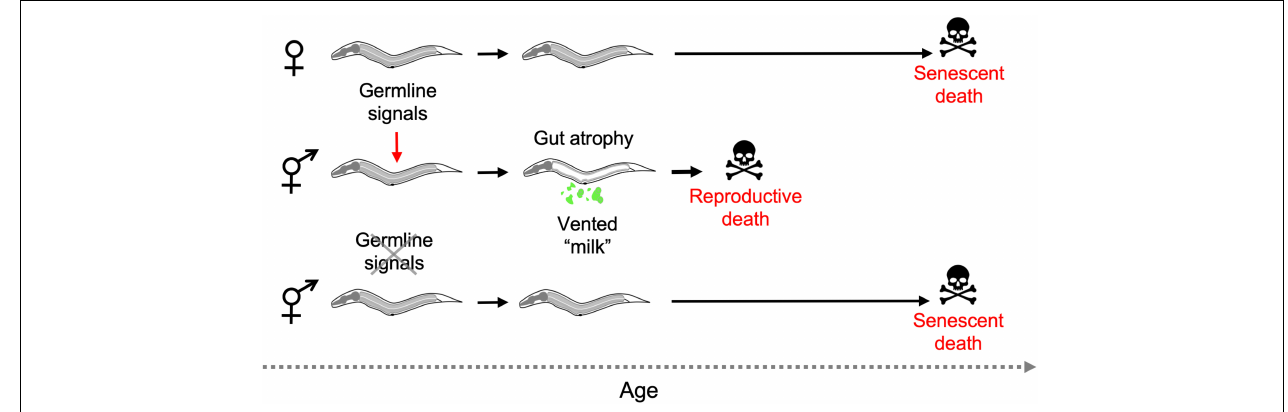
FIGURE 6 | Aging and death in Caenorhabditis females and hermaphrodites (simplified working model). In the absence of mating only hermaphrodites exhibit reproductive death, and this is triggered during reproductive maturation by signals from the germline. Removal of the germline by laser microsurgery blocks reproductive death, and markedly extends lifespan in hermaphrodites, removing the difference in lifespan between hermaphrodites and females. Germline ablation only modestly increases female lifespan (not depicted) (Kern et al., 2020).